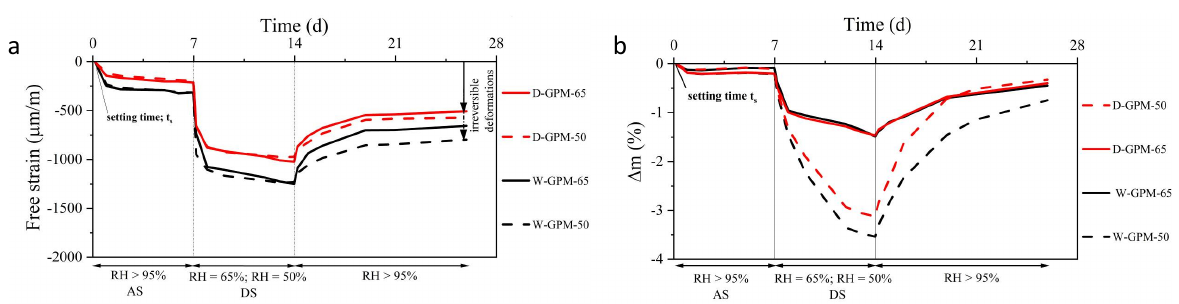
Figure 7. Hygric shrinkage and expansion during hardening under changing ambient conditions a) free strain and b) mass change Δ m. In the first period (0 ‐ 7 d) all samples were stored at 20°C and RH >95%. In the second period (7 ‐ 14 d), 3 samples of each mixture, W ‐ GPM as well as D ‐ GPM, were stored at 23°C and 50% RH and 3 samples at 20°C and 65% RH. In the last period (14 ‐ 25 d), the samples were all stored at RH >95%.